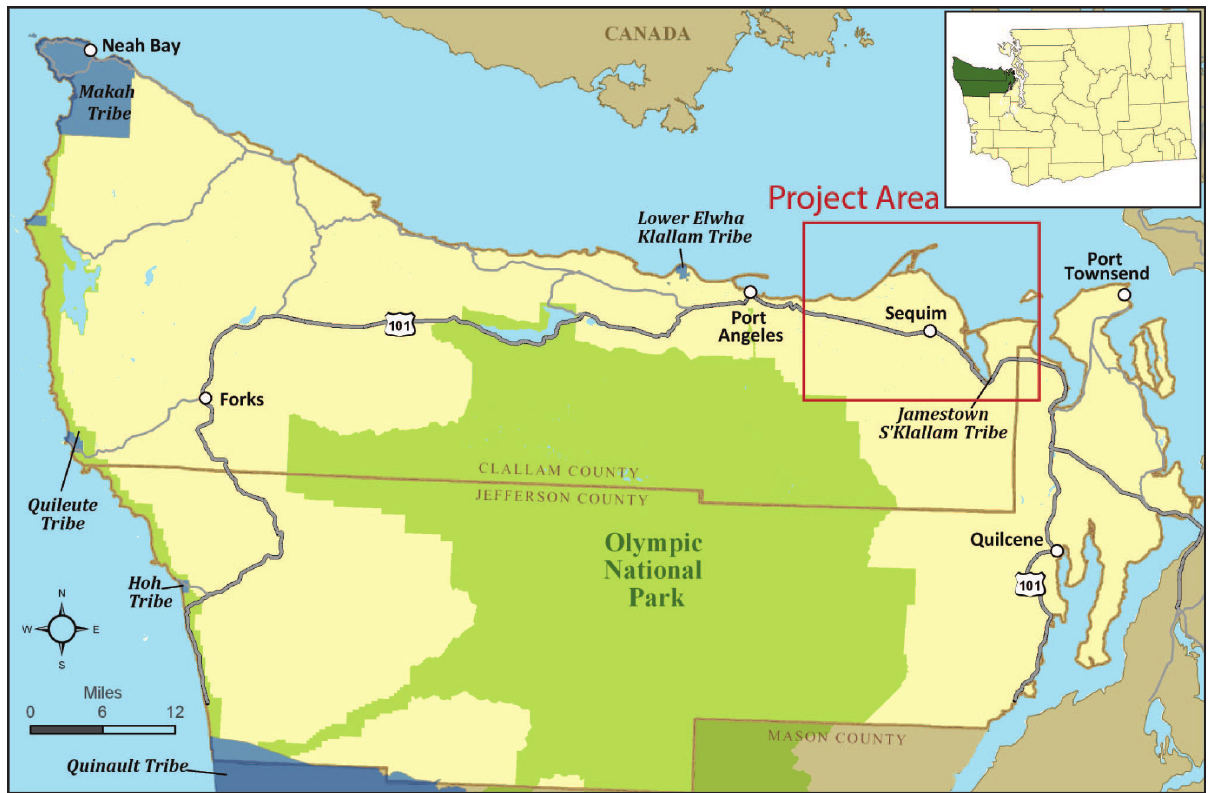
Figure 1: Map of the northern Olympic Peninsula in Washington State with the project area, the Dungeness Valley, outlined in red. The Dungeness Valley is the location of carrot seed production in Clallam County, and the area targeted for management of wild carrot. Map created by the